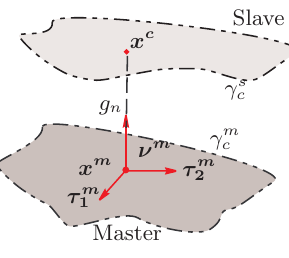
Fig. 2. Representation of the normal